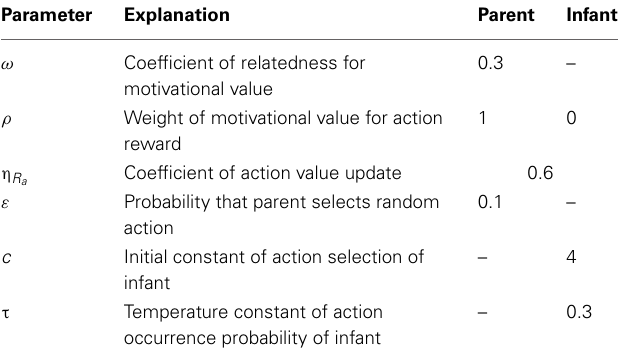
FIGURE 7 | Relatedness of virtual agent as a function of time in the simulated still-face